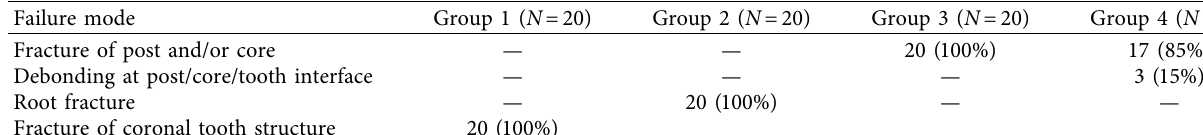
Table 4: Failure pattern observed for experimental groups.